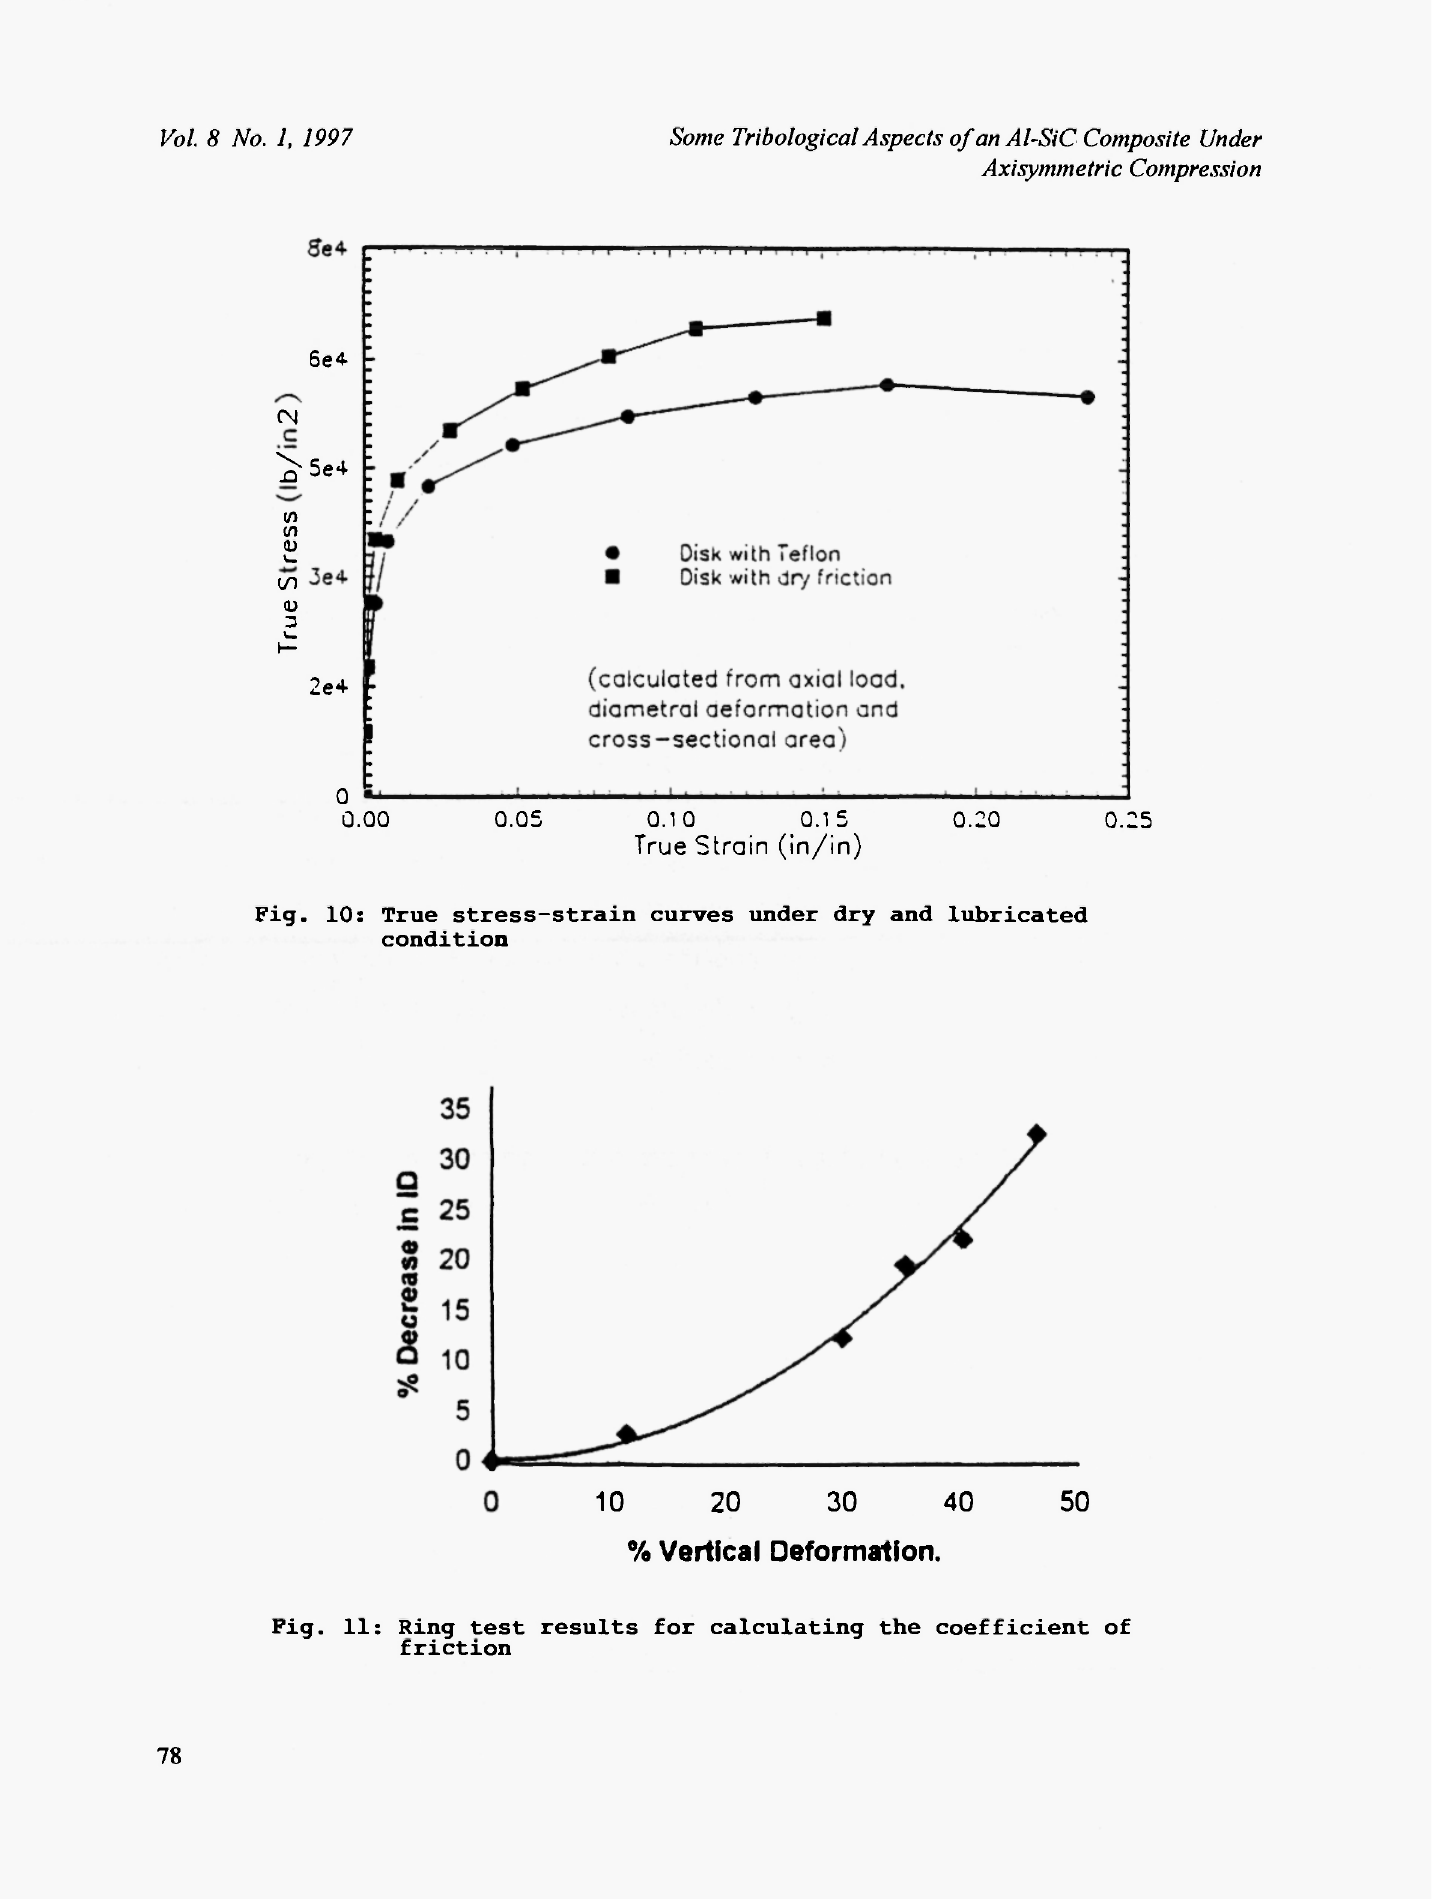
Pig. 11: Ring test results for calculating the coefficient of